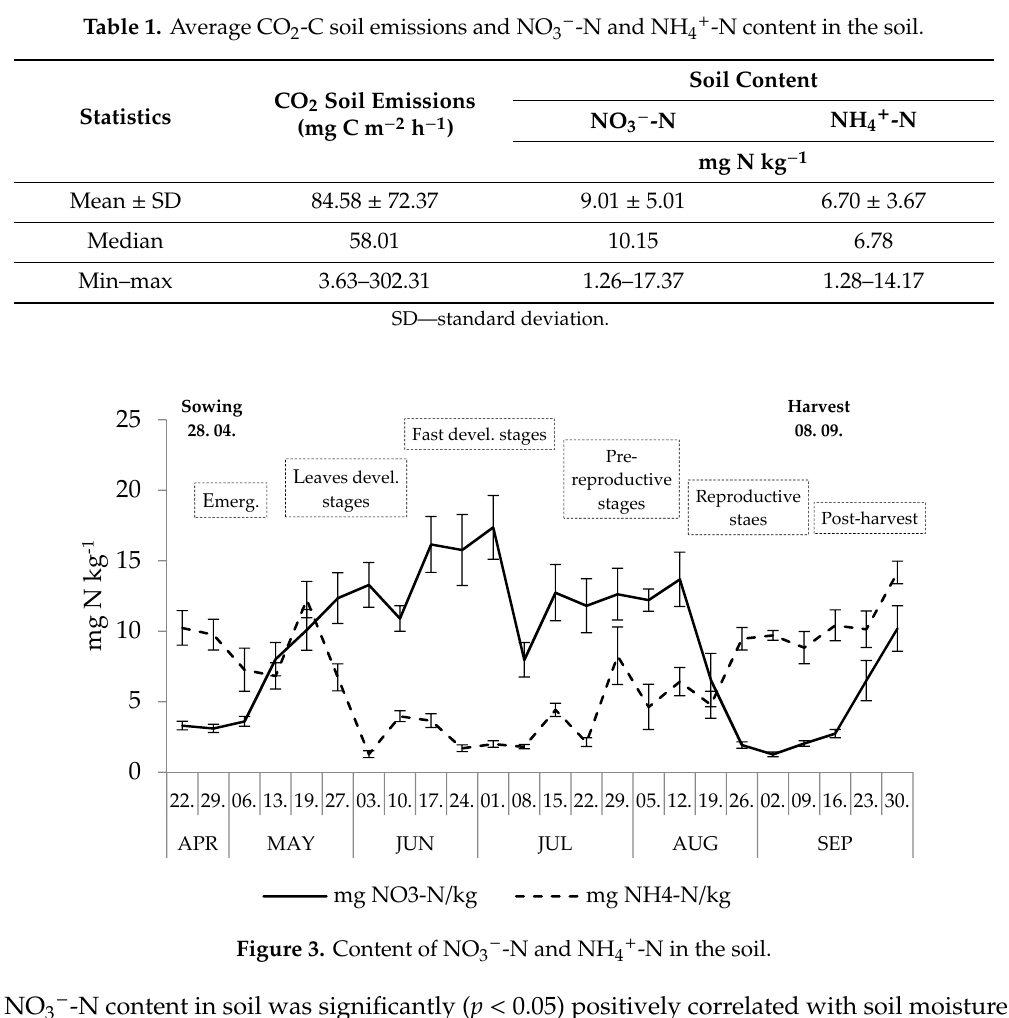
Table 1. Average CO 2 -C soil emissions and NO 3 − -N and NH 4 + -N content in the soil.